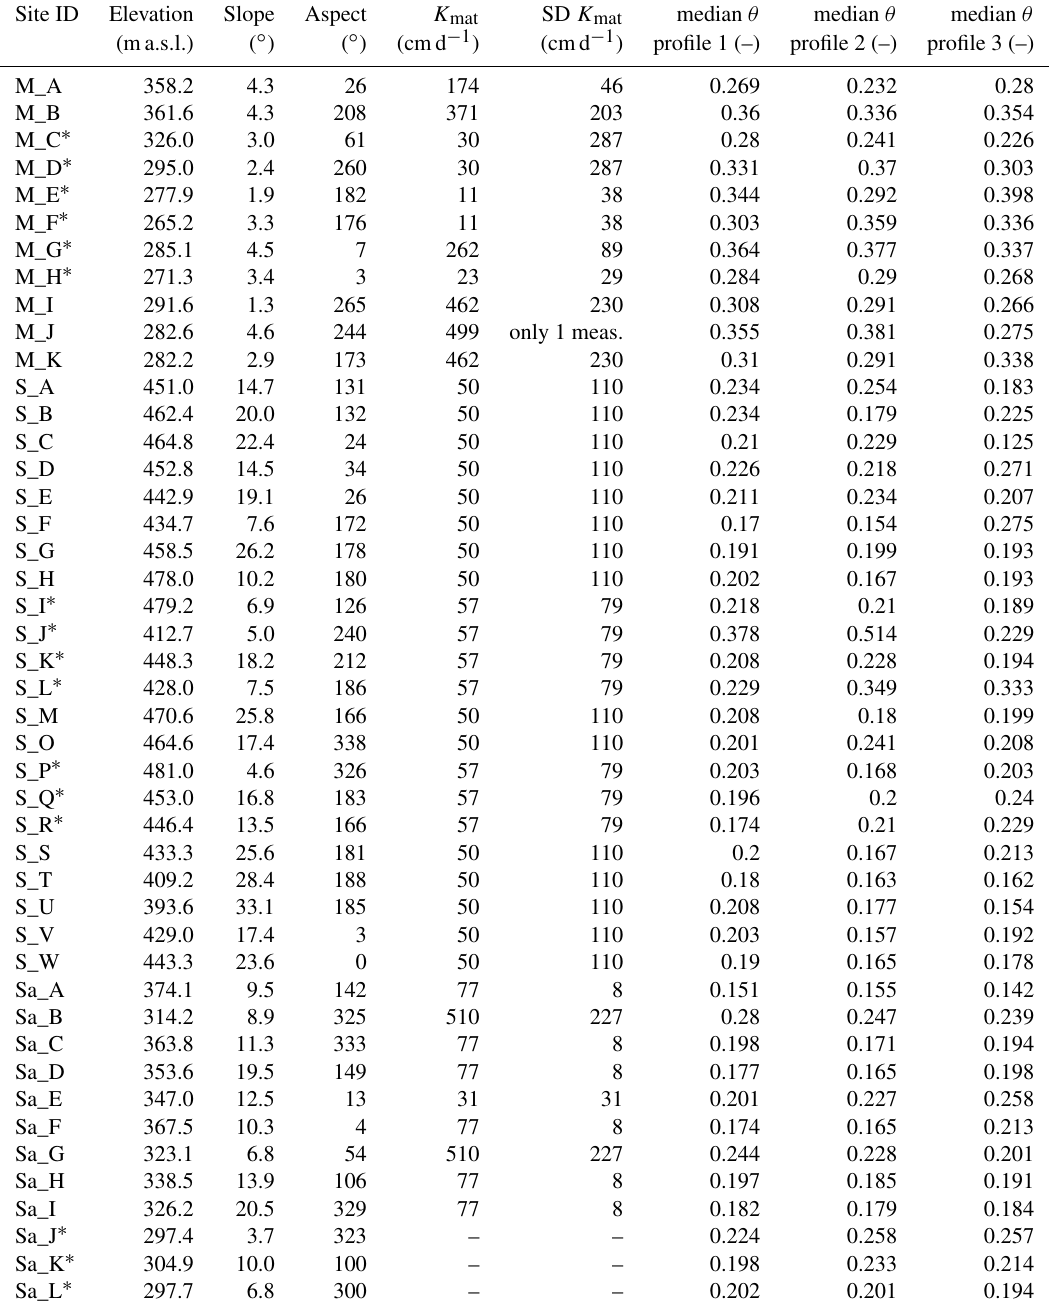
Table A1. S: slate; M: marl; Sa: sandstone. ∗ indicates grassland sites. SD: standard